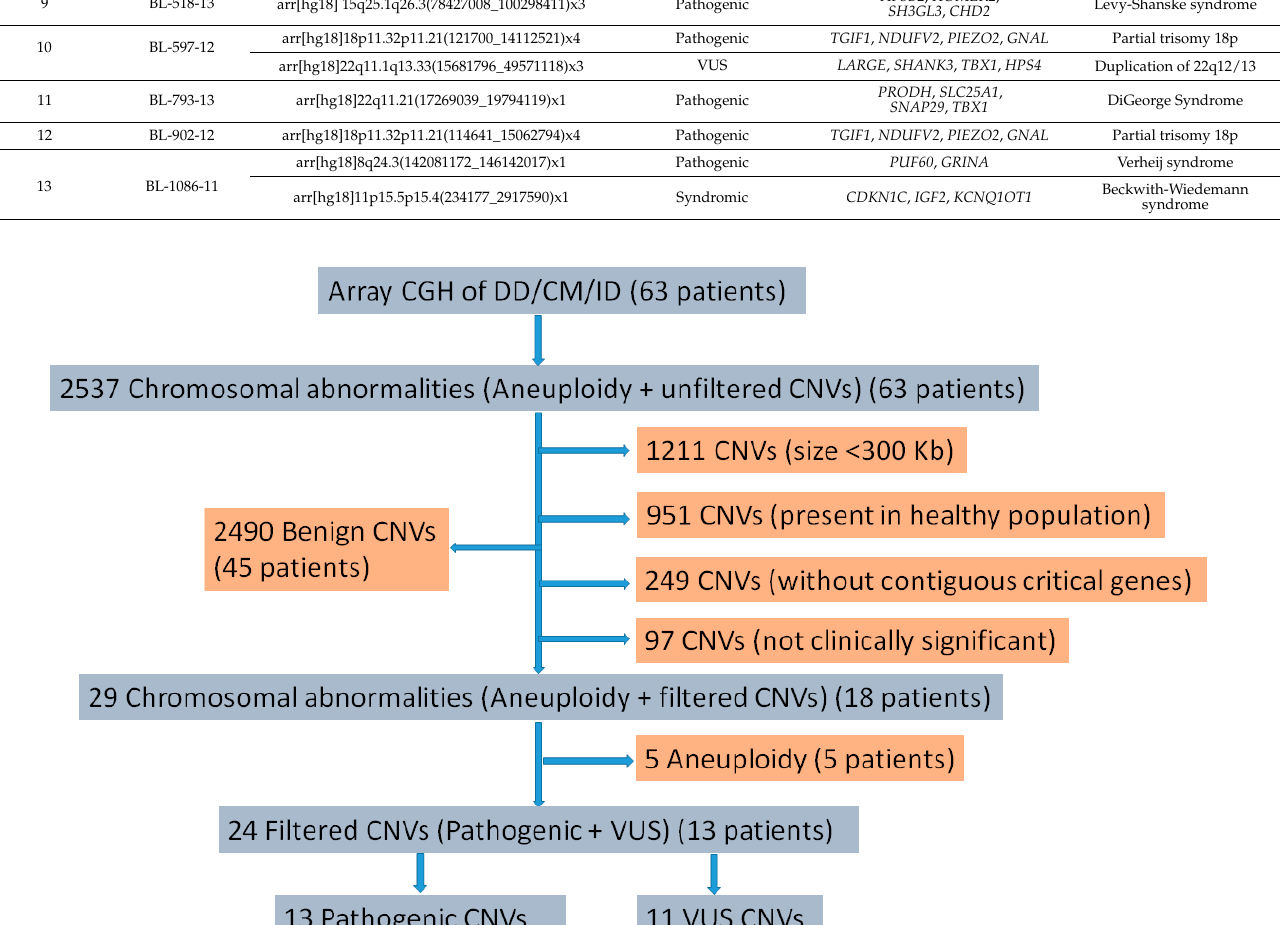
Figure 1. Flowchart for the filtration of pathogenic/VUS CNVs in Whole-Genome Array CGH results. Out of 2537 chromosomal abnormalities, 5 aneuploidy, 1211 CNVs of <300 Kb, 951 CNVs present in a healthy population, 249 CNVs without contiguous critical genes, and 97 non-clinically significant CNVs were removed to filter out 24 pathogenic/VUS CNVs among 13 DD/CM/ID patients. Based on their association with disease phenotypes and prevalence in previous studies and the OMIM database, the clinically significant CNVs were classified into two groups, specifically pathogenic (52%, 13/24 CNVs) and VUSs with variable effects (48%, 11/24 CNVs). Pathogenic CNVs were 8q24, 9p24p13, 10q26, 11p15, 22q11q13, 11q24q25, 15q25q26, and 16p13p11, and 18p11,. VUS CNVs were 3p23p14, 11q12.1q14, 13q21.1q32.1, 16q21q23, 18q23, 20q11.1q13.2, and 22q11q13. Interestingly, 22q11q13 was detected in at least four individuals, while 16q21q23.1 and 18p11.32p11.21 were found in three individ- uals. Table 2. Pathogenic and variants of uncertain signi fi cance and syndromic copy number variations detected by array CGH in pediatric developmental delay, congenital malformations, and intellectual disability patients.